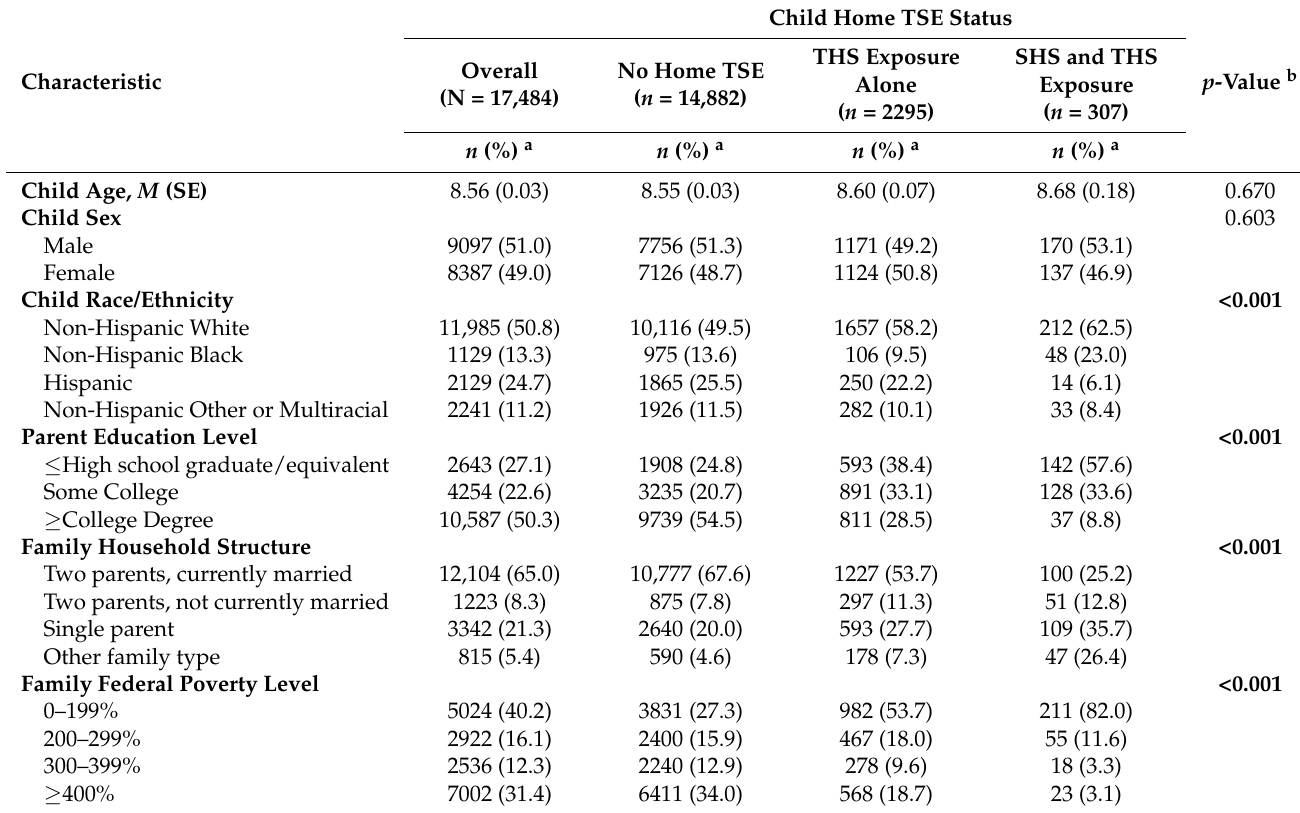
Table 1. Sociodemographic Characteristics and Child Home TSE Status among U.S.